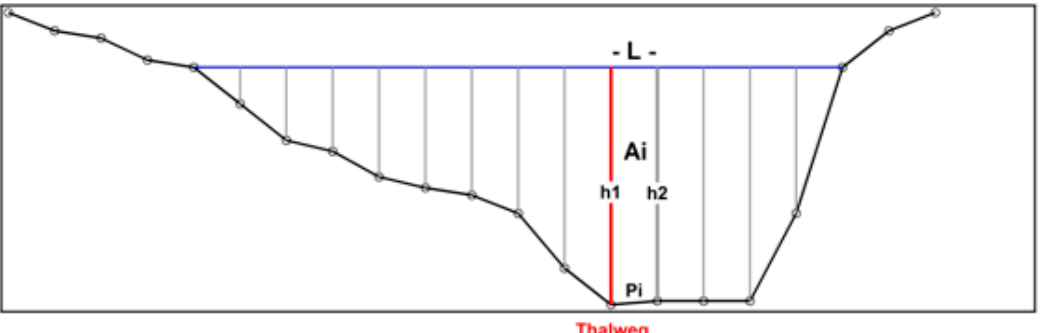
Figure 5. Each cross section in the BW zone was segmented to calculation units along with their associated nodes; A i is the segment area, L is the width of the segment, h 1 , and h 2 are depths at associated nodes, and P i is the wet perimeter of the segment.